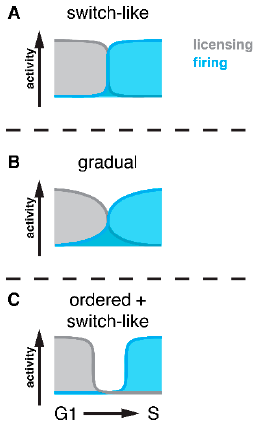
Figure 2. Separation of licensing and firing at cell cycle phase transitions. Three different models for transitions between replication phases are depicted here for the example of the G1/S transition. Note the temporal overlap of licensing (grey) and firing (blue) activity in the different models, indicating the potential for sporadic over-replication.